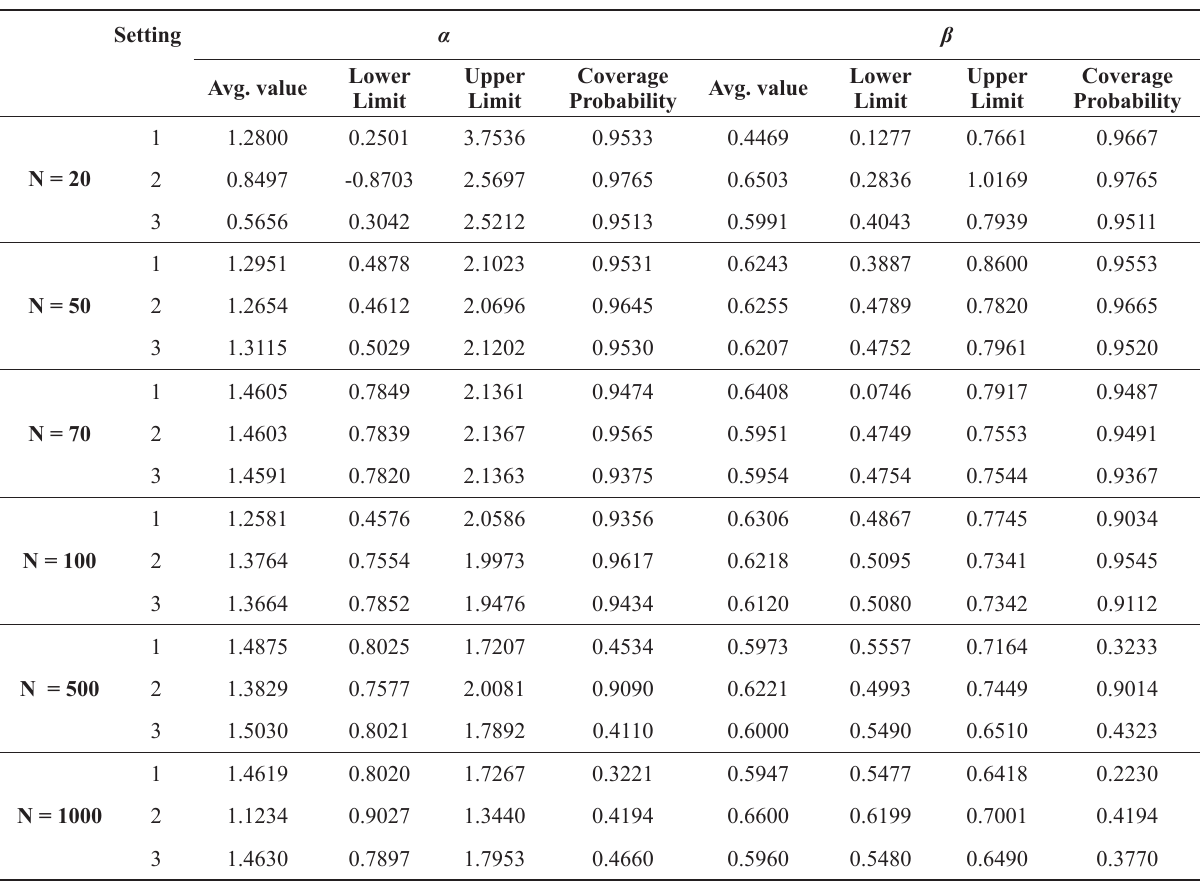
Table 3: Summary results of simulation for estimated values for α and β, their lower and upper 95% credible intervals, and coverage probabilities computed for different